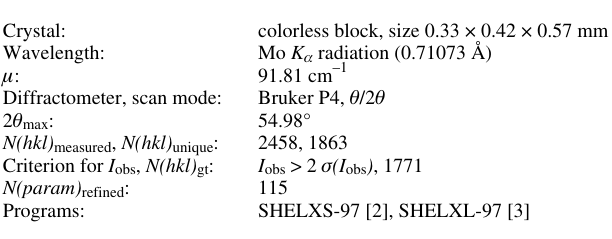
Table 1. Data collection and handling.